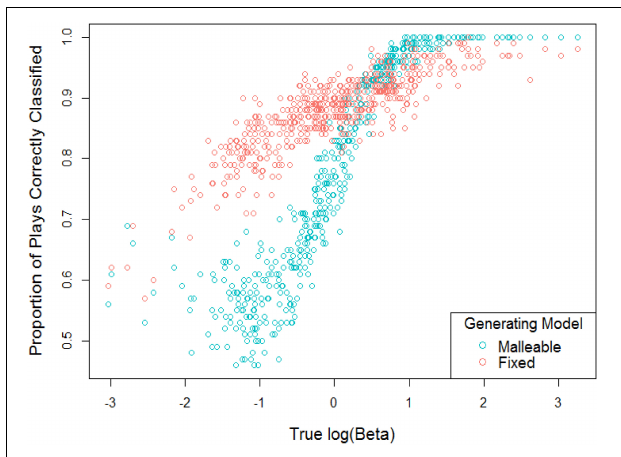
FIGURE 6 | Cultural mindset classification accuracy across replicated runs by simulated player.